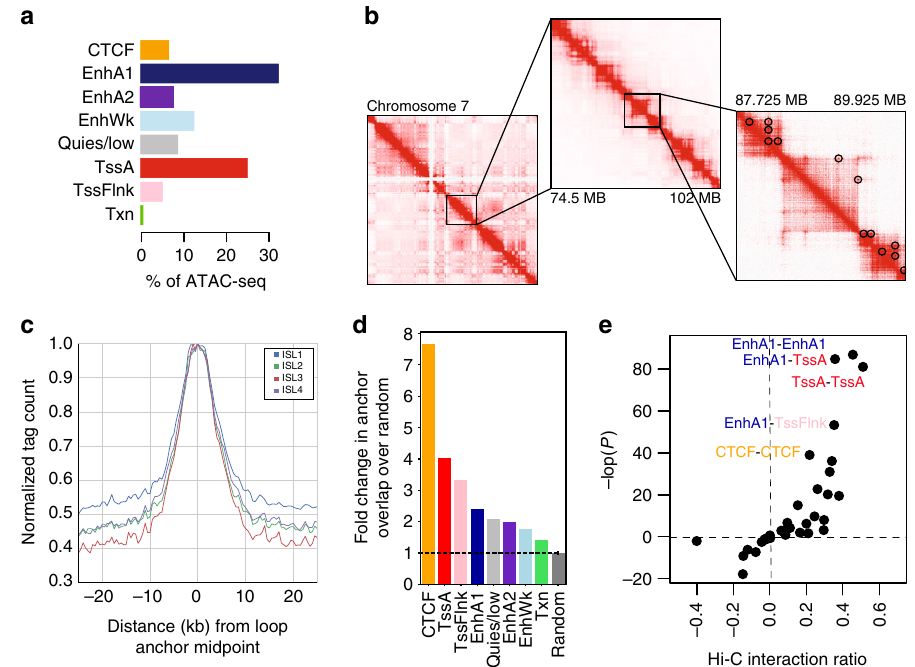
Fig. 1 Chromatin accessibility and conformation in pancreatic islets. a Islet accessible chromatin signal mapped predominantly within active enhancer (EnhA1) and promoter (TssA) states. b Chromatin looping from in situ Hi-C assays of three pancreatic islet samples at entire chromosome (left), 25 MB (middle) and 2 MB (right) resolution on chromosome 7. Black circles on the right panel represent statistically signi fi cant loop calls. c Accessible chromatin signal from four islet samples (ISL1-4) was distributed around chromatin loop anchor midpoints. d Islet chromatin loop anchors were enriched for islet CTCF-binding sites, as well as active enhancers and active promoters compared to random sites. Values represent fold change, and the error bar is SD. e Islet chromatin loops were most enriched for interactions between islet active enhancers and active promoter elements, and between CTCF-binding